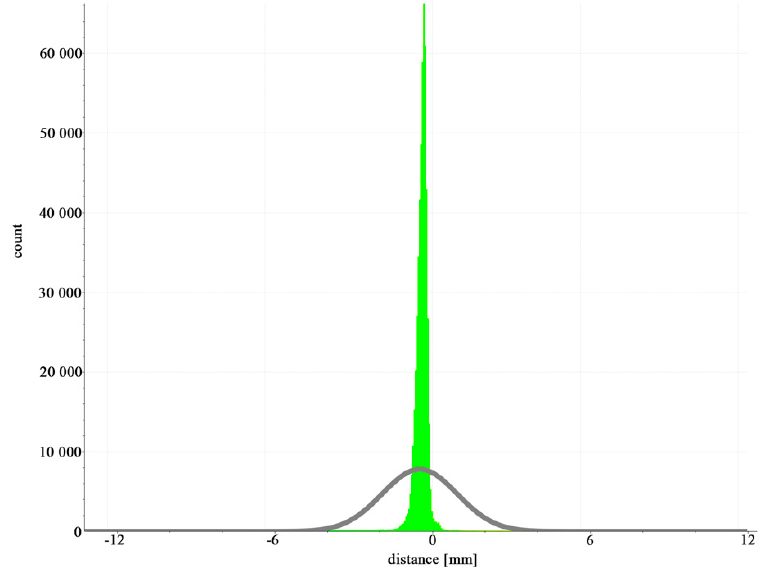
Figure 18. The frequency distribution graph.